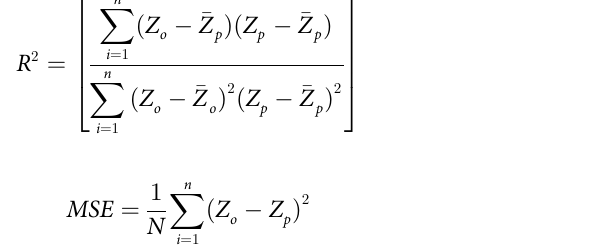
The prediction performance of both sets (training and testing) is evaluated by the coeffi- cient of determination (R 2 ) and mean squared error (MSE). The calculation formula is: